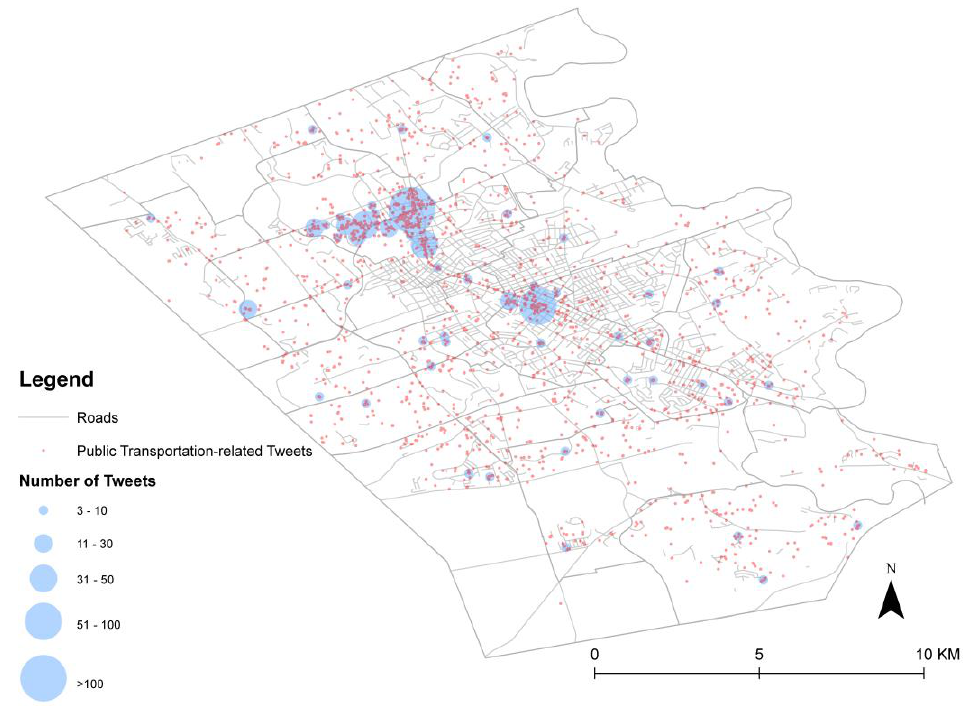
Figure 7. Spatial distributions of public transportation related tweets.